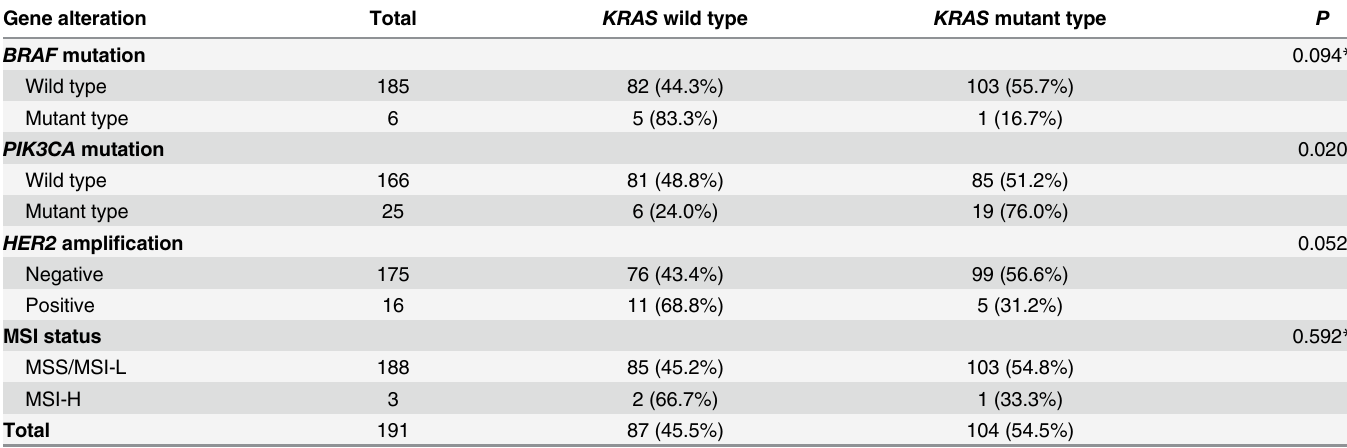
Table 2. Association of each genetic